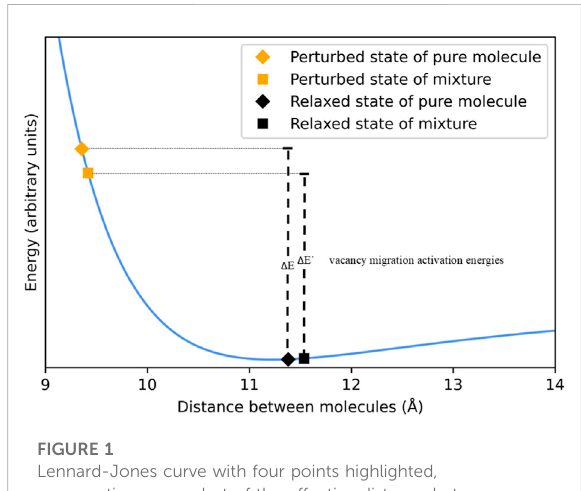
Lennard-Jones curve with four points highlighted, representing a snapshot of the effective distance between neighbors in both the relaxed and perturbed states of a mixture and a pure